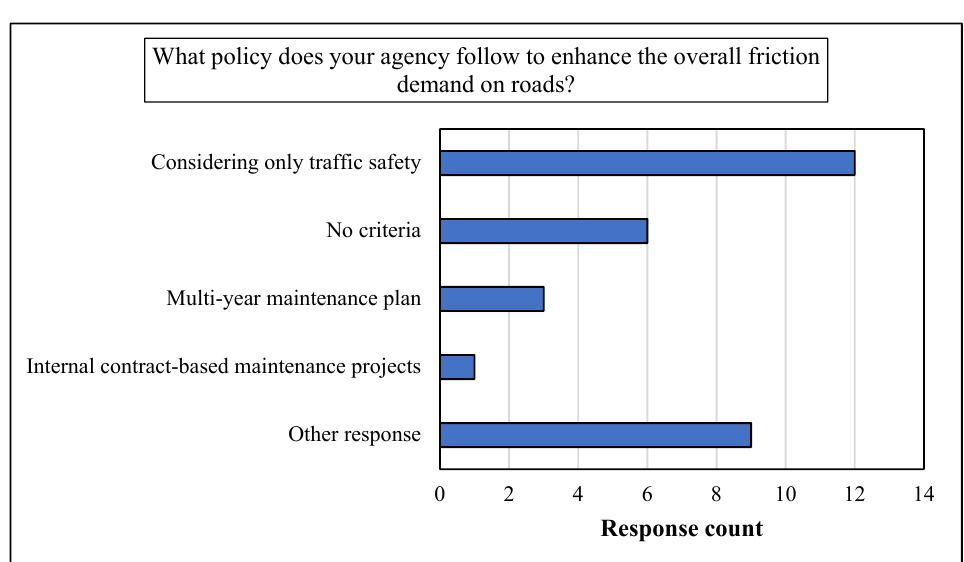
Figure 9. Overall criteria considered in decision making of managing pavement friction.